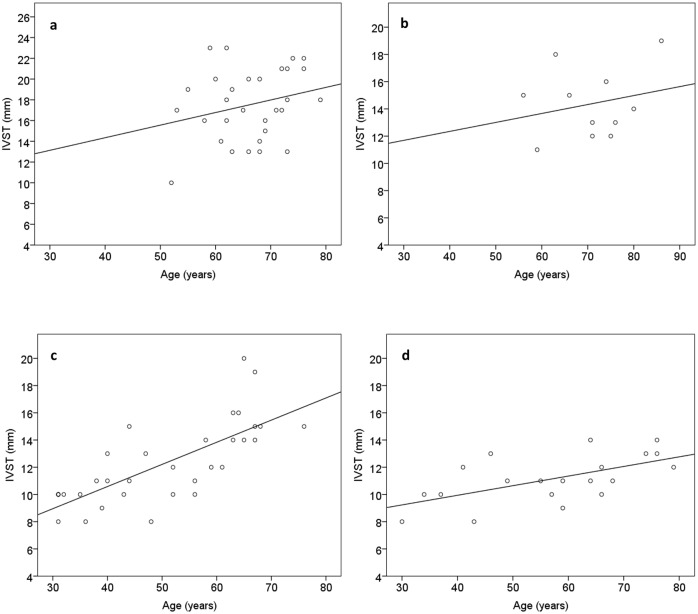
Scatterplot of interventricular septal thickness (IVST) in relation to age in.a) male patients with type A fibrils. The regression equation for ln IVST = 2.32+0.008*age, R2 = 0.073, p = 0.148. b) female patients with type A fibrils. The regression equation for ln IVST = 2.34+0.004*age, R2 = 0.052, p = 0.501. c) male patients with type B fibrils. The regression equation for ln IVST = 1.82+0.01*age, R2 = 0.563, p<0.0001. d) female patients with type B fibrils. The regression equation for ln IVST = 2.02+0.007*age, R2 = 0.364, p = 0.005.